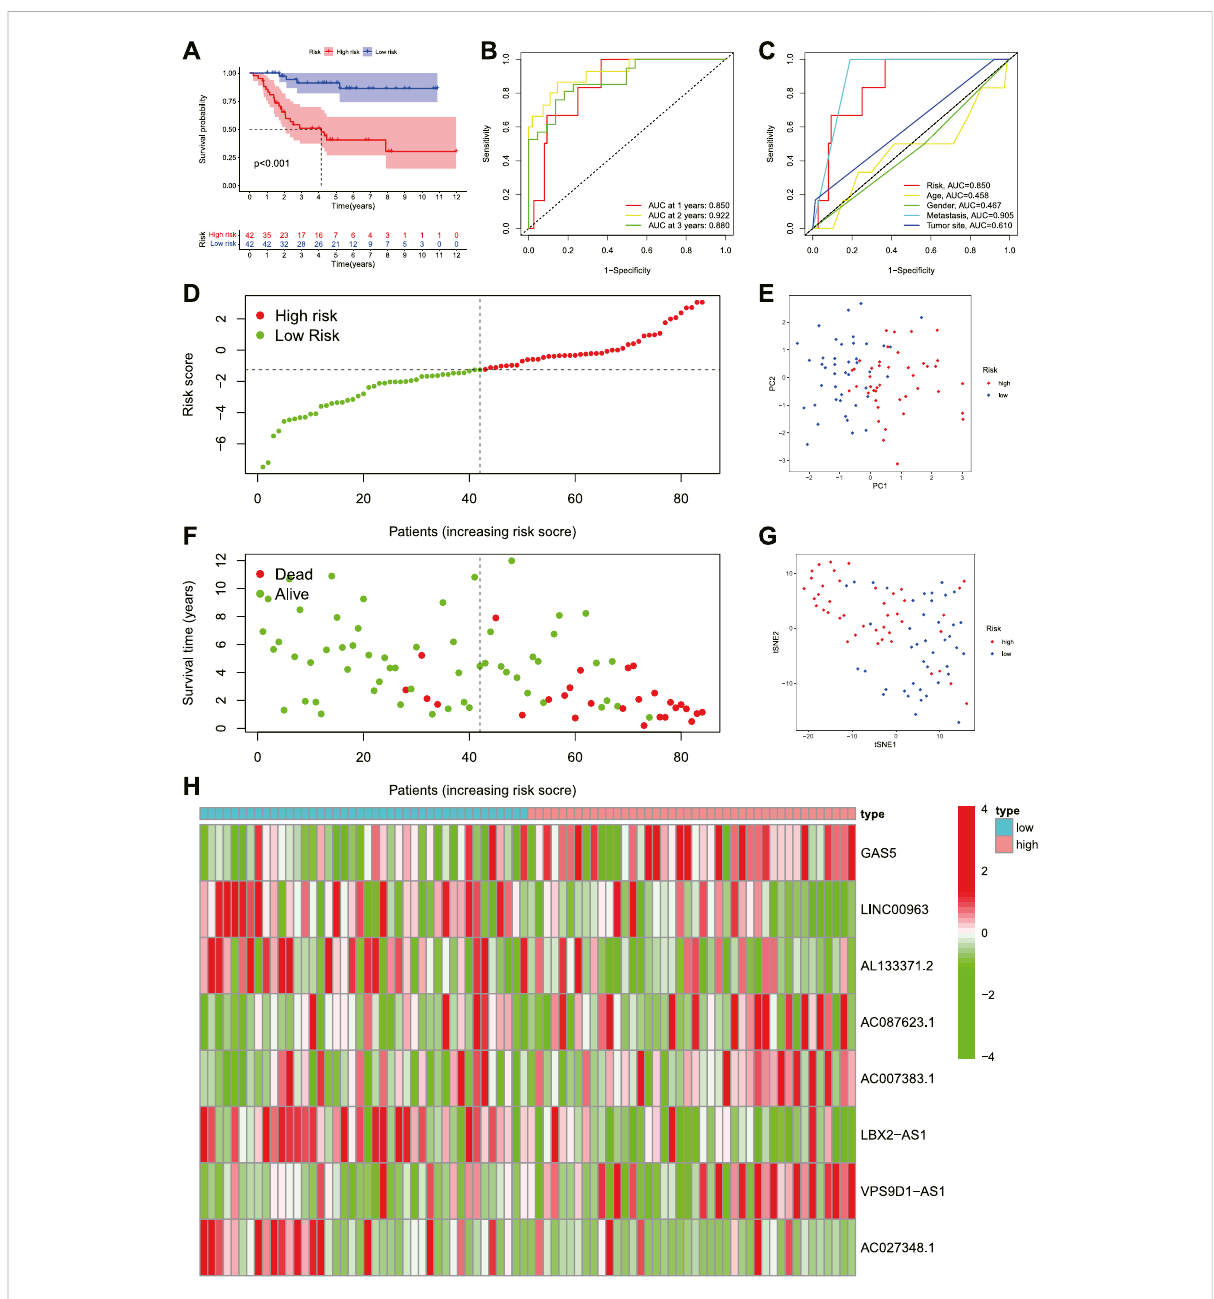
FIGURE 4 Prognosis value of the eight necroptosis-related lncRNAs signature. (A) . The outcome of the Kaplan-Meier curves. (B) . The AUC values for predicting OS survival rates at 1, 2, and 3 years. (C) . The AUC values of the risk variables. (D) . Distribution of patient risk ratings. (E) . The PCA plot. (F) . Plot of risk survival status. (G) . The t-SNE plot. (H) . Heatmap of lncRNAs associated with necroptosis in high- and low-risk